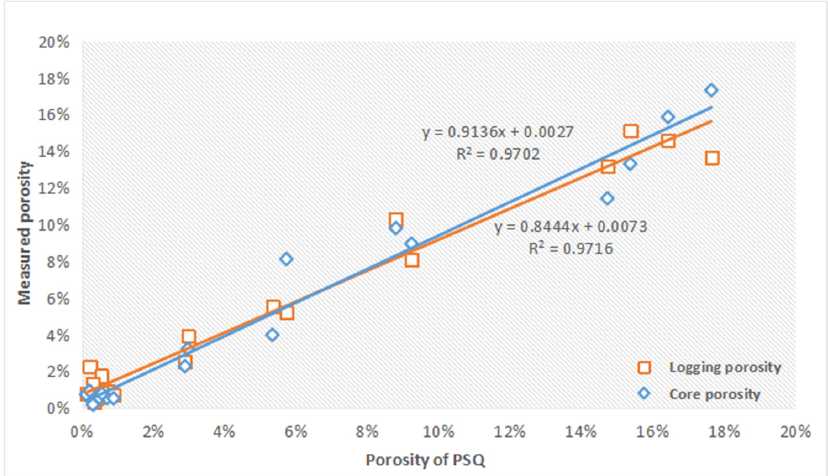
Figure 6. Linear graph of porosity of PSQ and measured porosity in Well Shutan 1.